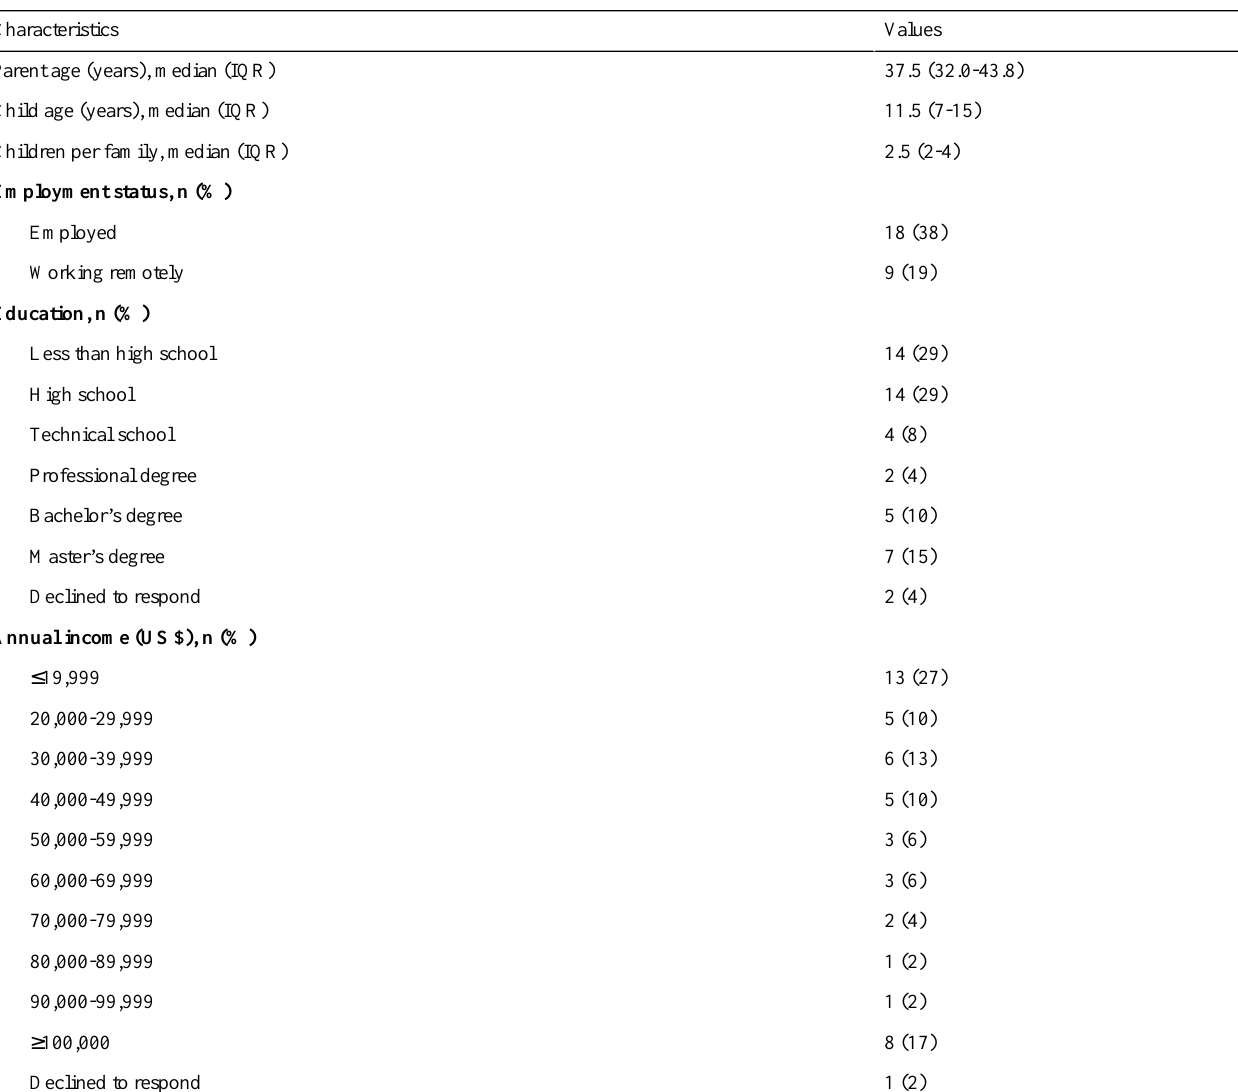
Table 1. Demographic characteristics of the parents included in this study (N=48).